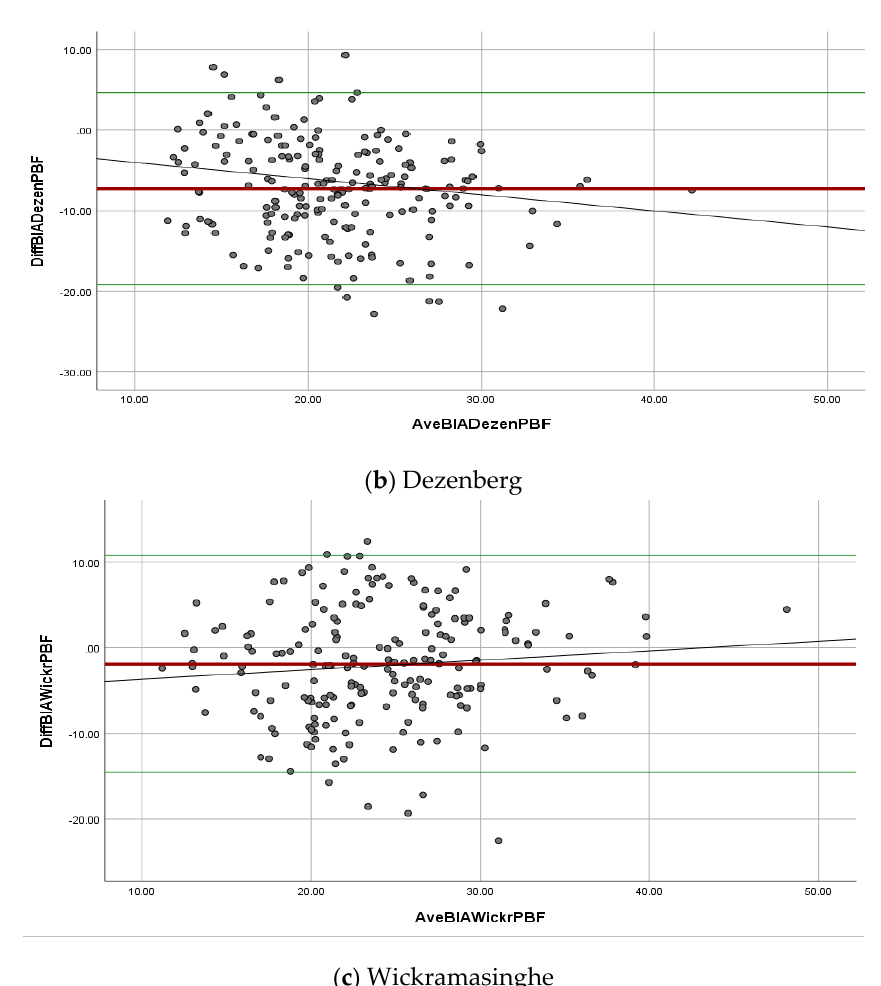
Figure 2. ( a – c ): shows the Bland and Altman plots for the mean differences between calculated and measured %BF obtained from BIA and the Slaughter et al. [22], Wickramasignhe et al. [24], and Dezenberg et al. [25] skinfold equations, with upper and lower 95% confidence intervals (CI). [Figure legends: Bland – Altman plots with regression lines of %BF obtained from BIA against those estimated from the skinfold equations of 1(a) Slaughter et al., (b) Wickramasinghe et al., and (c) Dezenberg et al. The y-axis represents the differences between bioelectrical impedance analysis (BIA) and Slaughter prediction equation for body fat (DIFFBIASlaughterBF/Wickramasinghe/Dezenberg), and the x-axis represents the means between BIA and the skinfold prediction equation for body fat DIFFBIASlaughterBF/Wickramasinghe/Dezenberg. The dotted line represents the negative slope, and the solid line represent the mean regression line].